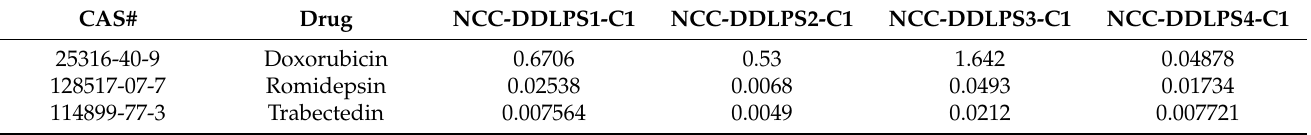
Table 3. Summary of half-maximal inhibitory concentration (IC 50 ) values ( µ